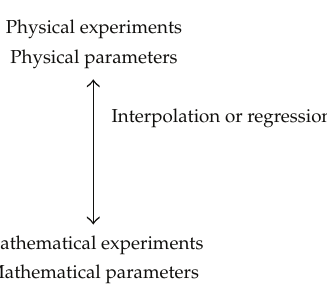
Figure 7: Coupling of physical and mathematical parameter